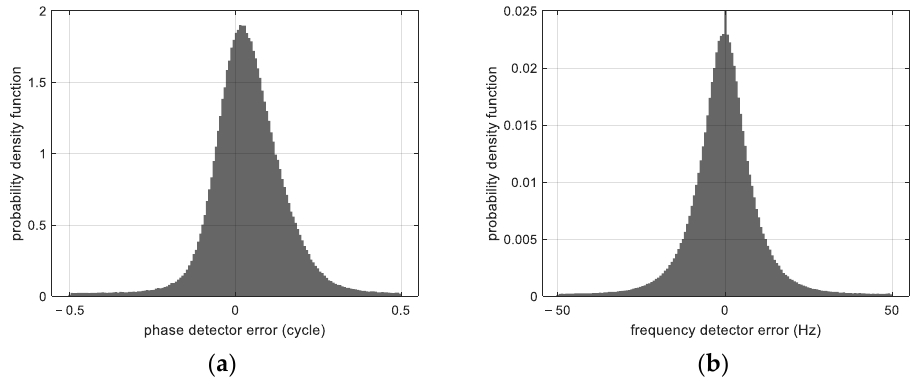
Figure 6. ( a ) Probability density function of the phase detector error, ( b ) Probability density function of the frequency detector error.